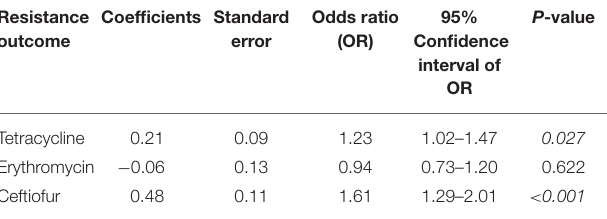
TABLE 7 | The three logistic regression models depicting the association between year of isolation and tetracycline-, erythromycin-, and ceftiofur resistance among Streptococcus uberis ( n = 228) associated with bovine mastitis in northern Thailand during 2010–2017.